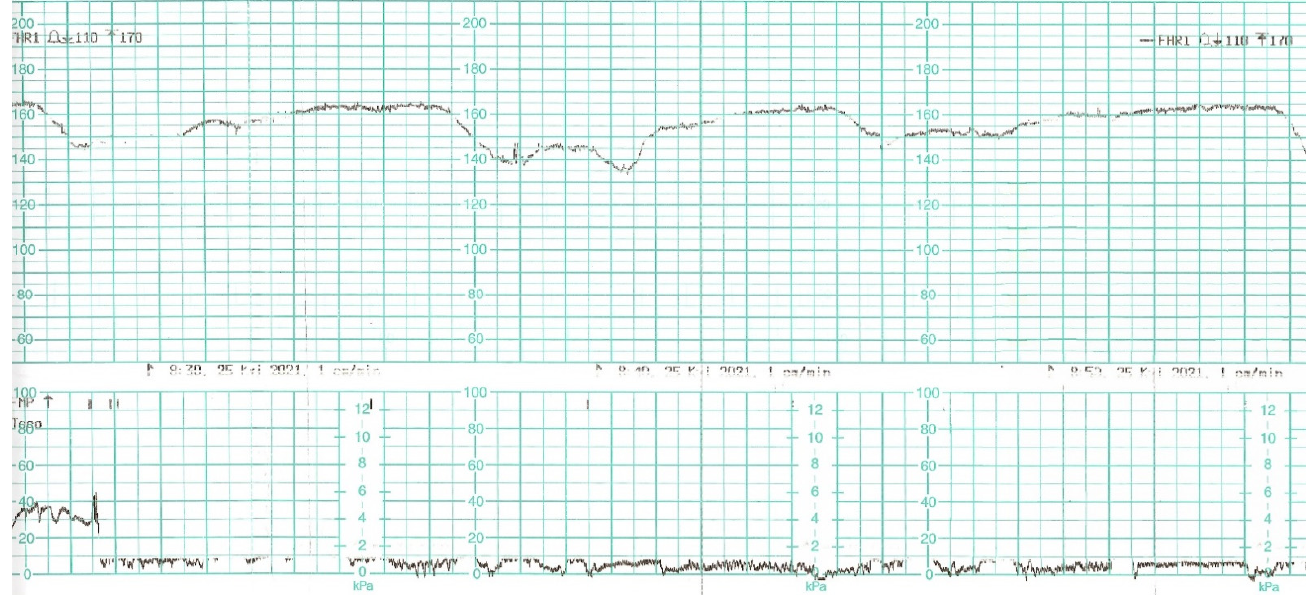
Figure 1. Cardiotocography recording in a patient 1—normal baseline, reduced variability.